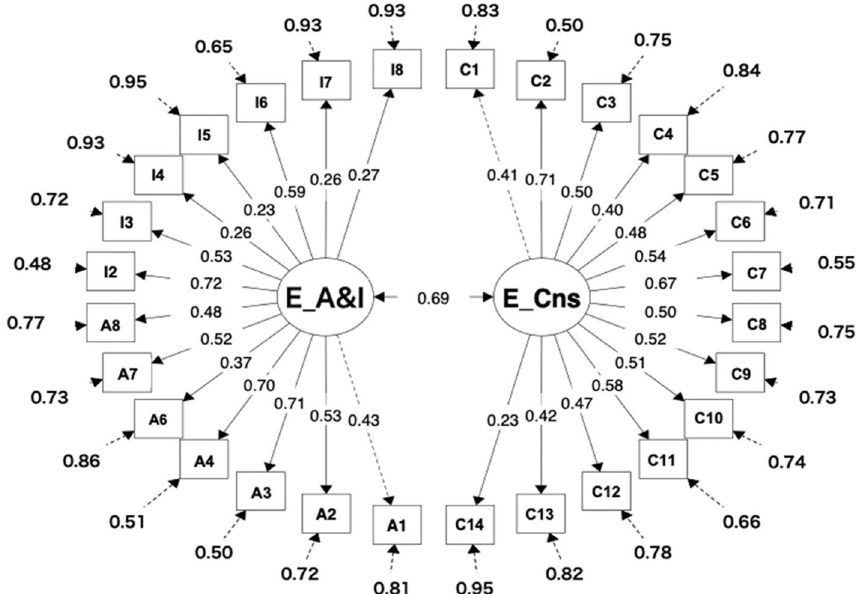
Fig. 2 Final two-factor correlated model of ECTT. Notes. All the estimates are standardized and significant ( p < .001); E_A&I ECTT Analysis and Inference, E_Cns ECTT Consistency. χ 2 (349) = = .86, AGFI .84, SRMR .10, CFI 1.000, RMSEA .00 [.00, = = = =